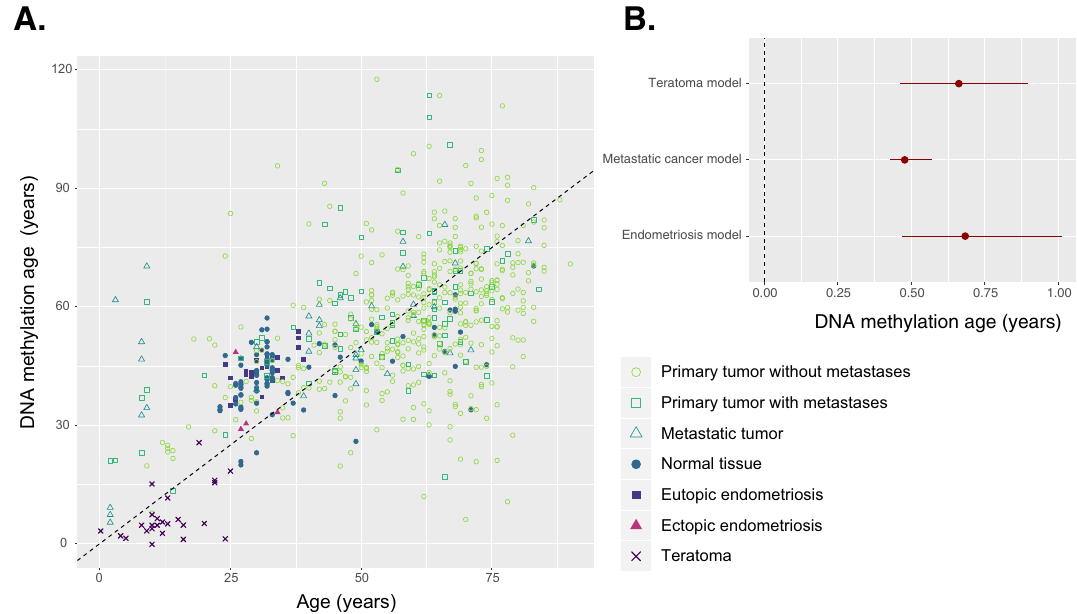
Figure 1. ( A ) Correlation between chronological age and predicted DNA methylation age. Dashed line indicates the identity line where perfectly correlated points would be found. Open shapes are cancerous tissues; filled shapes are non-cancerous. ( B ) Age parameters estimated from each of the three multivariate models; point estimate and bootstrapped 95% confidence interval are shown. A value of 0 would indicate that age does not affect DNAm age; a value of 1 would indicate that for every 1 year increase in age, DNAm age increases by 1